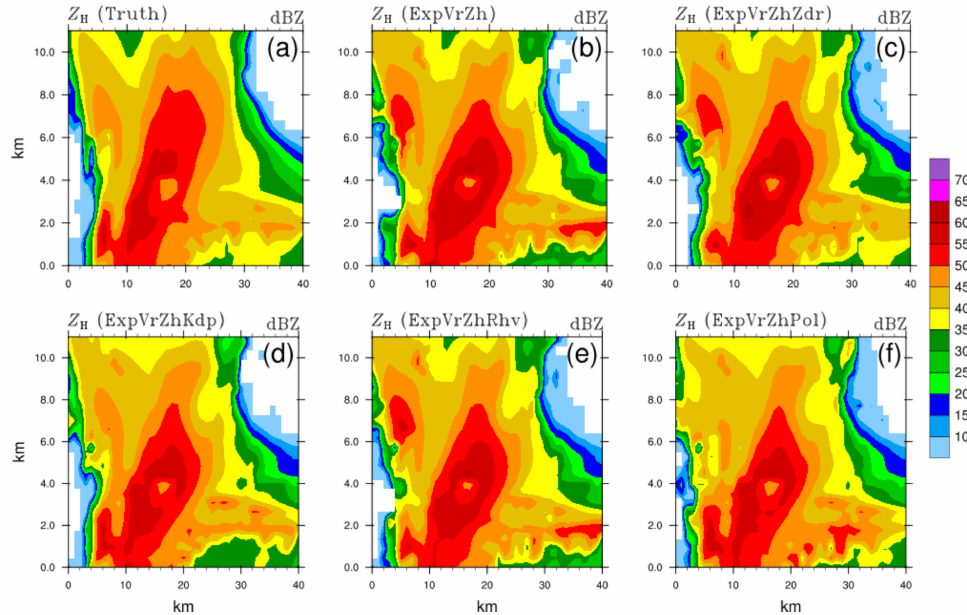
Figure 7. Vertical cross-sections of reflectivity Z H along the black dashed line in Figure 3a for ( a ) truth, and analysis fields of ( b ) ExpVrZh, ( c ) ExpVrZhZdr, ( d ) ExpVrZhKdp, ( e ) ExpVrZhRhv, and ( f ) ExpVrZhPol, respectively.